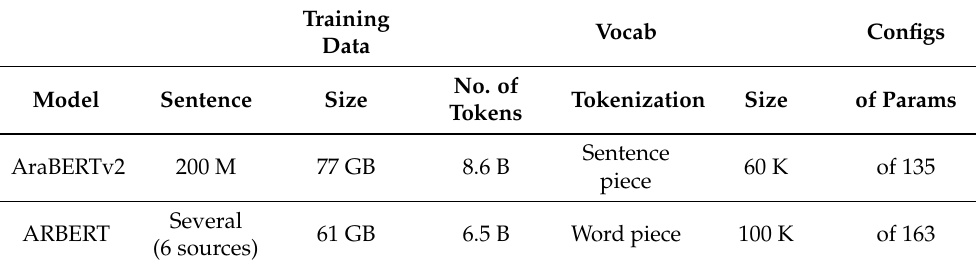
Table 3. Arabic pretrained